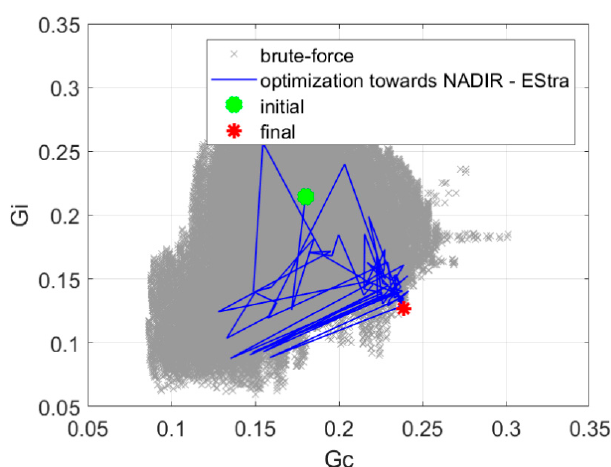
Figure 11. The history of optimization in the space of objective function components for optimization with nadir point distance maximization.